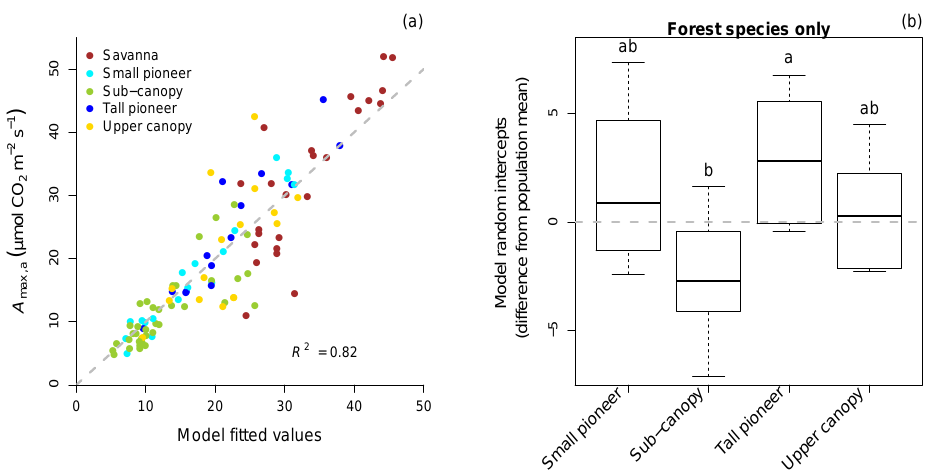
Figure 6. Output from linear mixed-effects model (Eq. 2): (a) scatterplot of observed photosynthetic capacity ( A max , a ) against the model- fitted values as an indication of goodness of fit and (b) boxplot of model random intercepts ( A max , a ↔ [N] a ) by φ for the F subset; boxes which share the same letter correspond to means that were not significantly different (Tukey’s HSD on ranked values). Boxplot construction is explained in Fig. 1. Table 5. Output of the linear mixed-effects model (Eq. 2): fixed effects (top) and random effects (bottom). The top section shows fixed-effect parameter estimates and associated standard error (SE), degrees of freedom, test statistic and associated p value. The final “optimal” model is compared against a simpler “null” model that includes only vegetation type ( b ) in the fixed component, but has an identical random term of species nested within site. Continuous explanatory variables were centred on their respective means (i.e. zero reset to the trait average). Final model Null model Fixed effect Estimate SE d f t value p value Estimate SE d f t value p